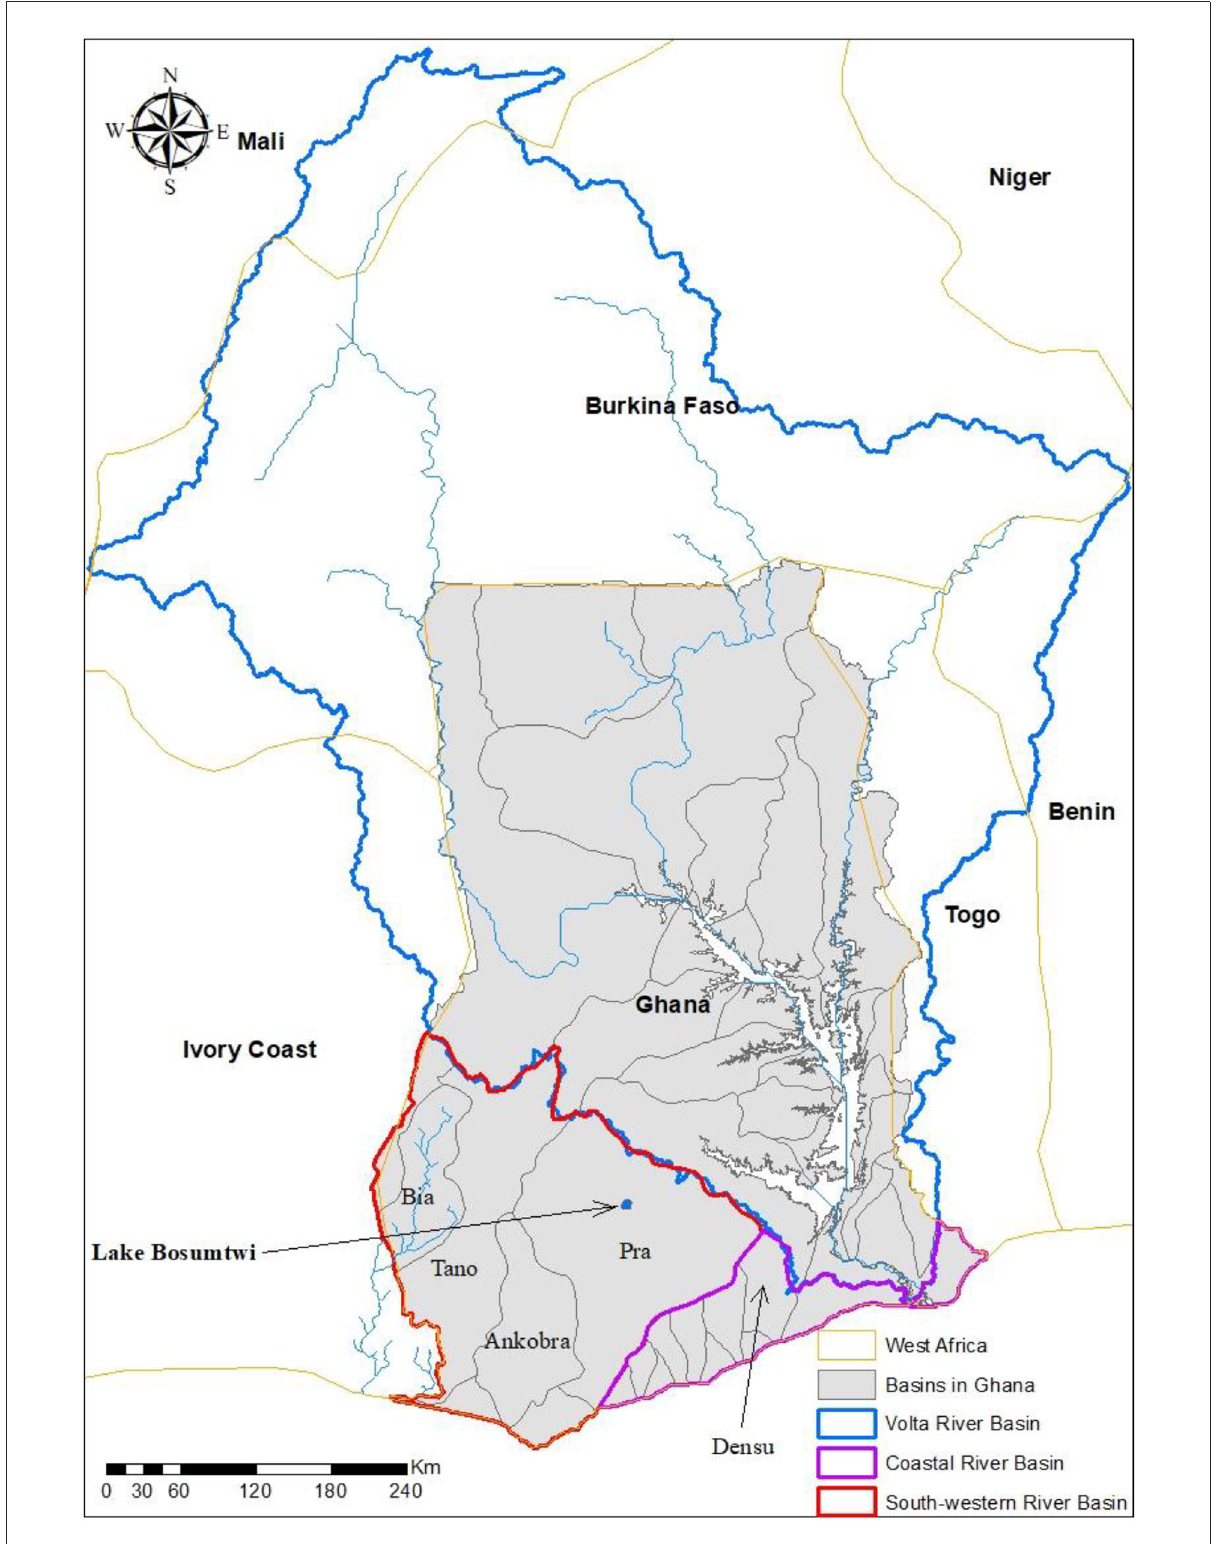
FIGURE1 Basin demarcation for the 3 river systems in